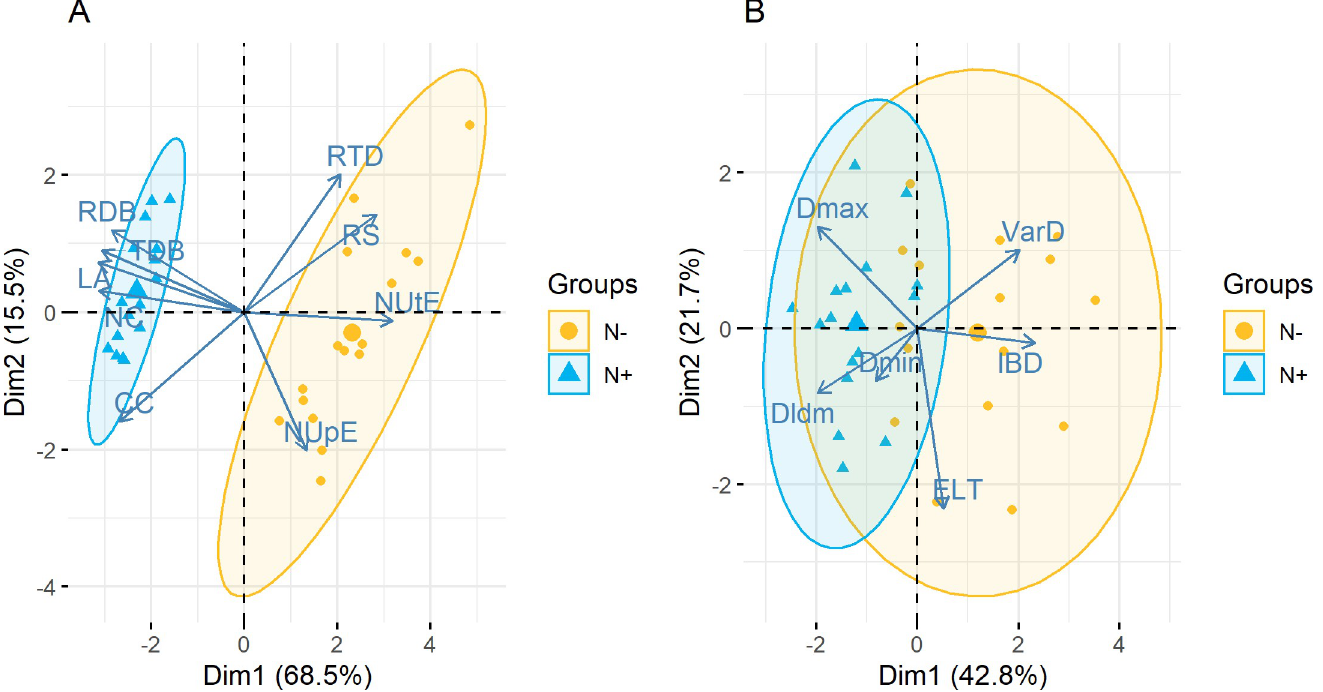
Fig 3. Principal component analysis. Trait values and individual positions for PA traits (A) and RSA traits (B) projected on the first plane of the principal component analysis defined by the first two components. RDB: Root Dry Biomass; TDB: Total Dry Biomass; LA: Leaf Area; NC: Nitrogen Content; CC: Carbon Content; RTD: Root Tissue Density; RS: Root:Shoot Ratio; NUtE: Nitrogen Utilization Efficiency; NUpE: Nitrogen Uptake Efficiency; VarD: Lateral root diameter variation; IBD: Inter-Branch distance; ELT: Root elongation rate by root diameter; Dmin: Root minimal diameter; Dldm: Root Hierarchy; Dmax: Root maximal diameter. Colours represent N treatments (blue for N+ plants and orange for N- plants). Biggest dots represent the mean position of the considered group (N+ or N- ). Ellipses are two-dimensional projections of the 95% confidence interval.